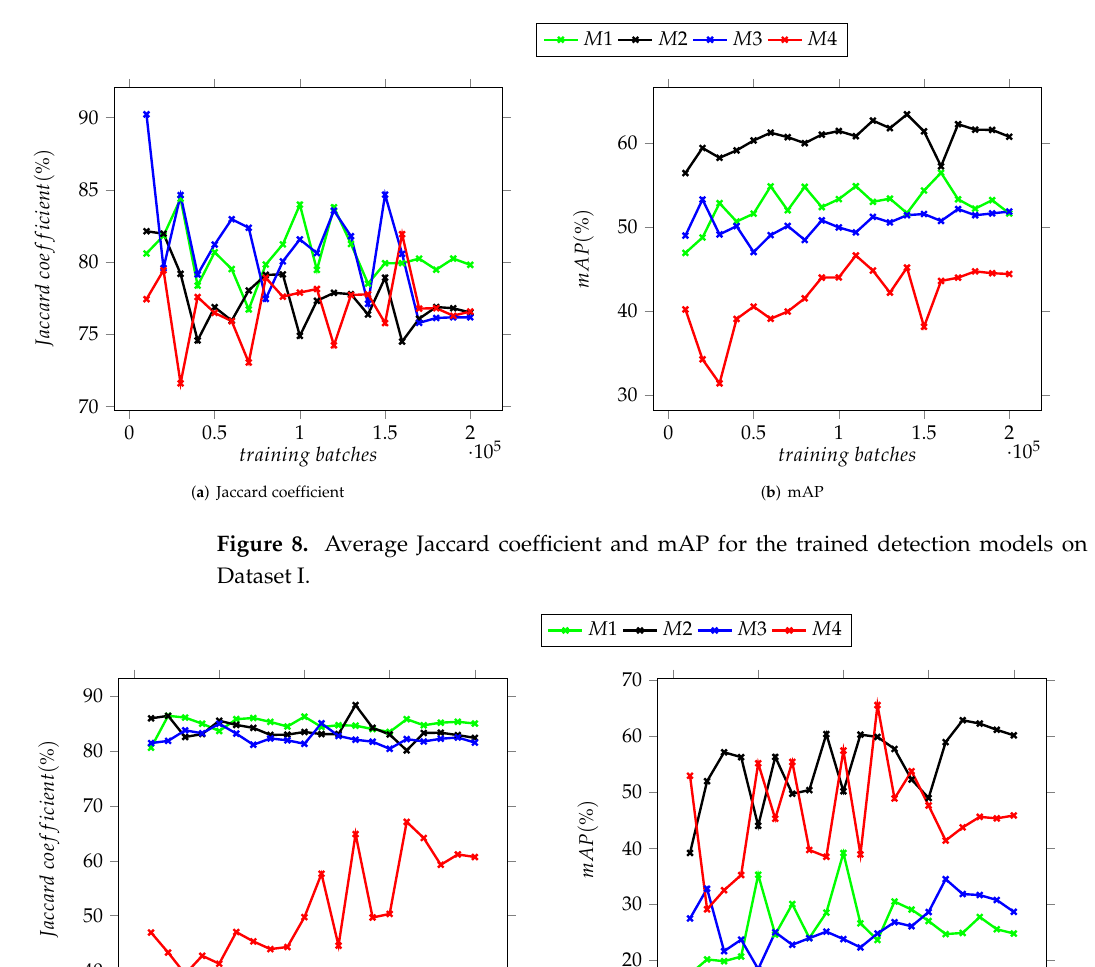
Table 5. Detection results for all models on the validation Dataset I.